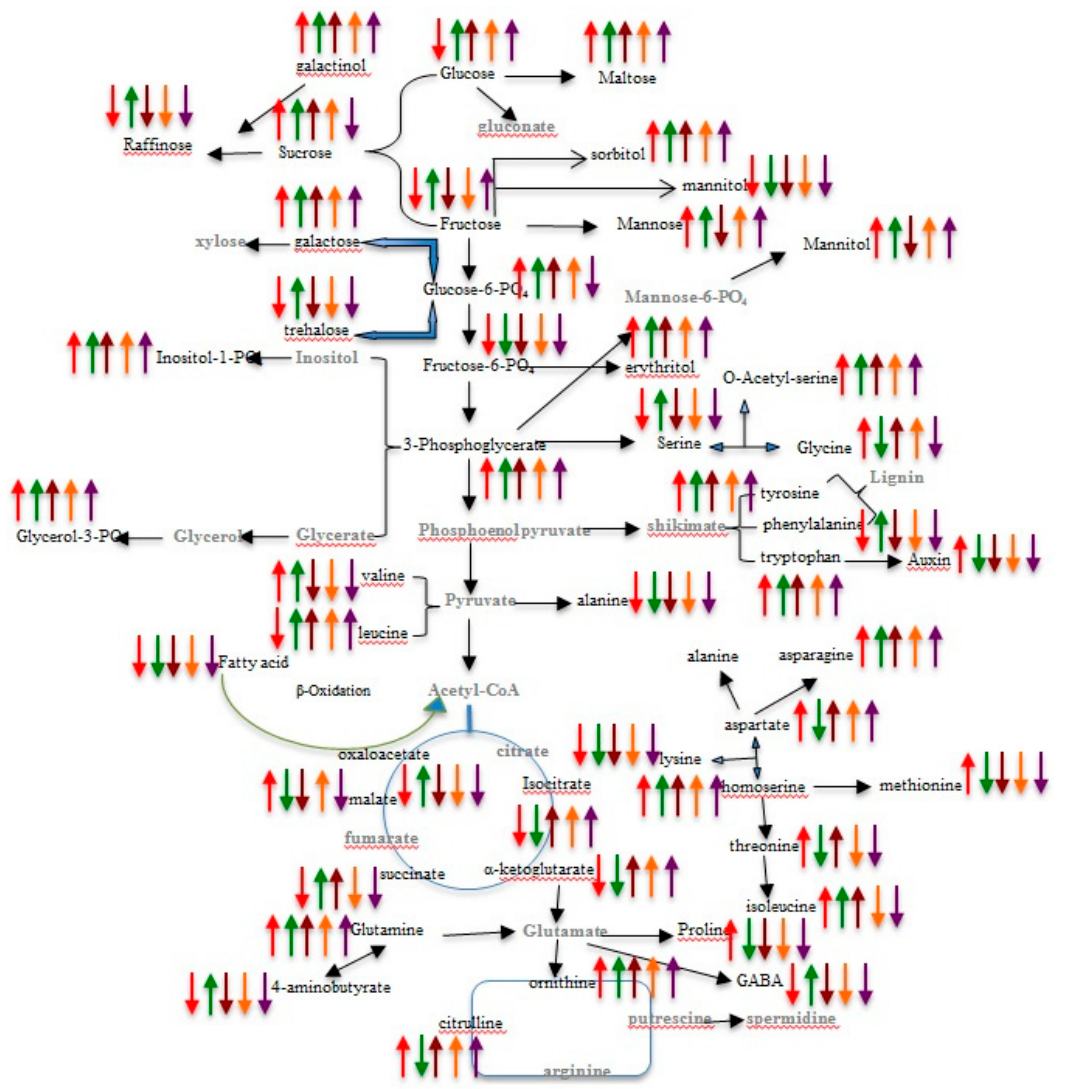
Figure 5. Comparative changes in the metabolites involved in primary metabolic pathways of leaves and roots of LNT (PEHM-2) and LNS (HM-4) genotypes in response to N deficiency. The detected and undetected metabolites are represented by black and grey notation respectively. The red and green arrows indicate LNT and LNS genotypes, respectively, while arrows in brick red, light yellow and purple indicate the restoration samples at the 3rd, 6th and 10th day (3DR, 6DR and 10DR) respectively. The metabolites found to have upregulated or downregulated under low-N conditions are represented by upward-pointed and downward-pointed arrows respectively.